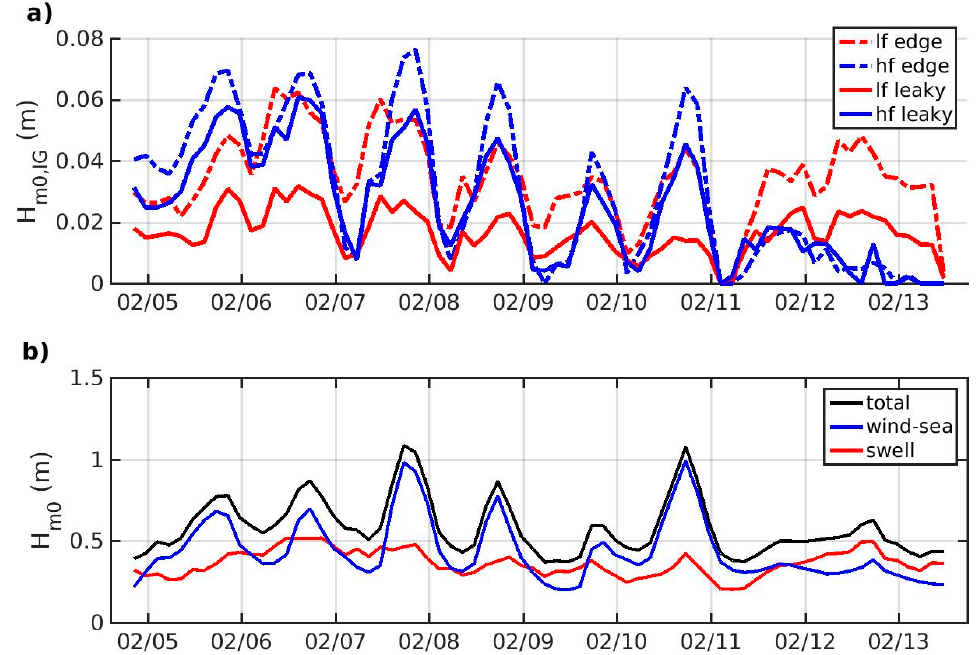
Figure 8. ( a ) Time series of ( a ) H m0,IG from the f-k y spectra (Appendix A, Figure A1), for two frequency ranges: 0.005–0.023 Hz (low frequency (lf), red and 0.023–0.050 Hz (high frequency (hf), blue) and for edge waves (dashed lines) and leaky waves (solid lines). ( b ) Significant wave height time series averaged over three hours, total (black), wind-sea (blue) and swell (red).